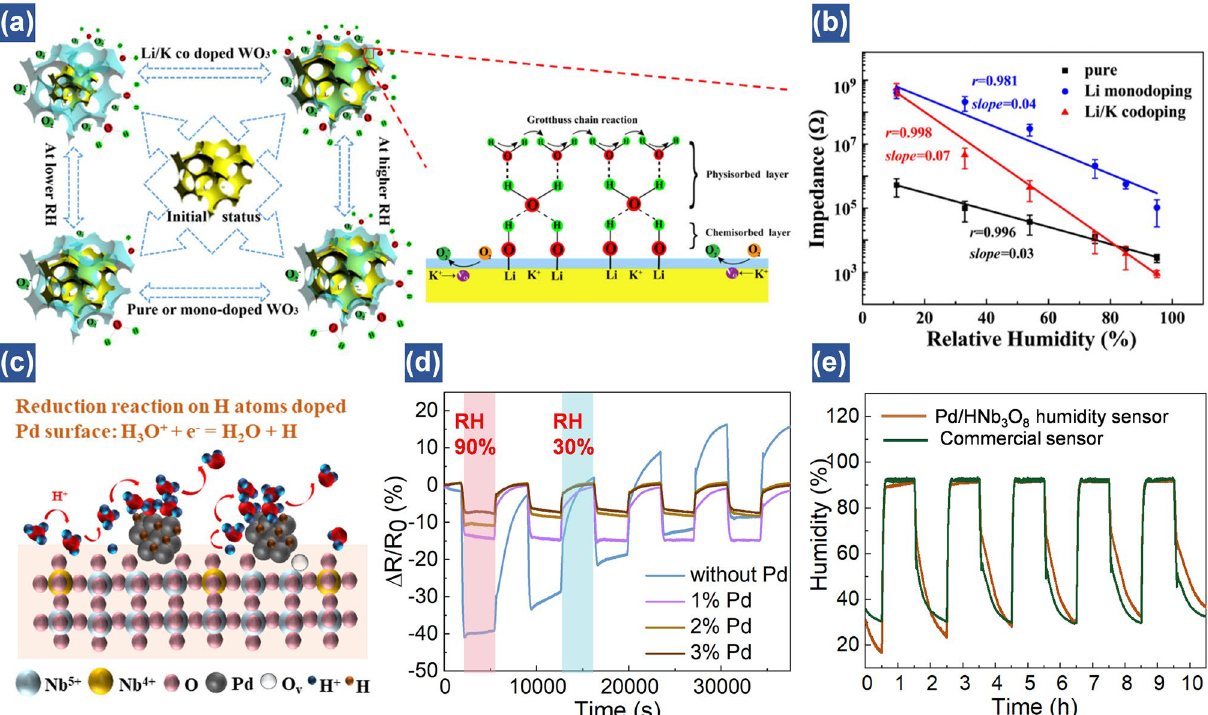
Fig. 7 Performance enhancement via chemical doping and surface modification. ( a ) Humidity-sensing mechanism of 3D ordered materials (3DOM) samples. ( b ) Impedance of 3DOM samples under each RH [42]. Copyright 2018 ACS Publications. ( c ) Schematic of the reduction reaction on the H atom assembled Pd/HNb 3 O 8 nanosheet surface under high RH. ( d ) Cycling tests of HNb 3 O 8 humidity sensors with different Pd contents and humidity variations from 30 to 90%. ( e ) Long-term cycling tests of a 1% Pd/HNb 3 O 8 humidity sensor compared with that of a com- mercial humidity sensor under the same RH [46]. Copyright 2021 Royal Society of